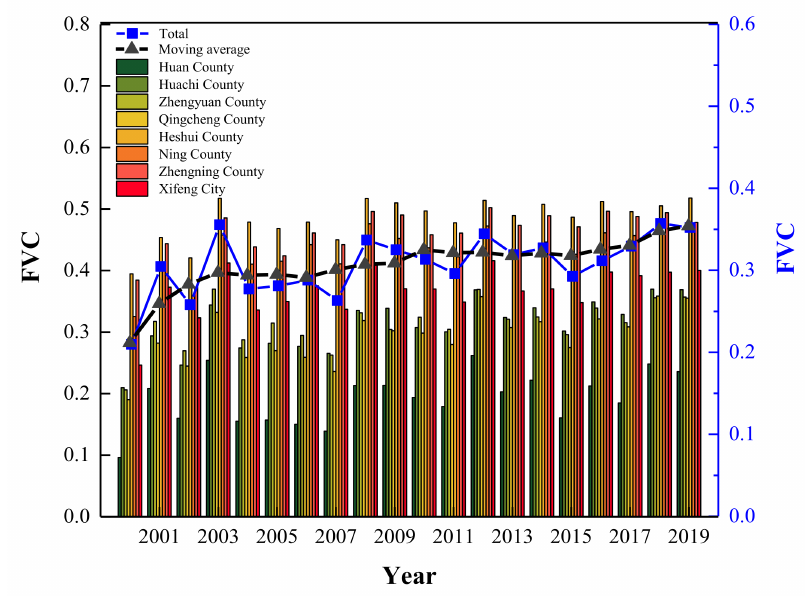
Figure 4. Annual records of FVC in Qingyang from 2000 to 2019.